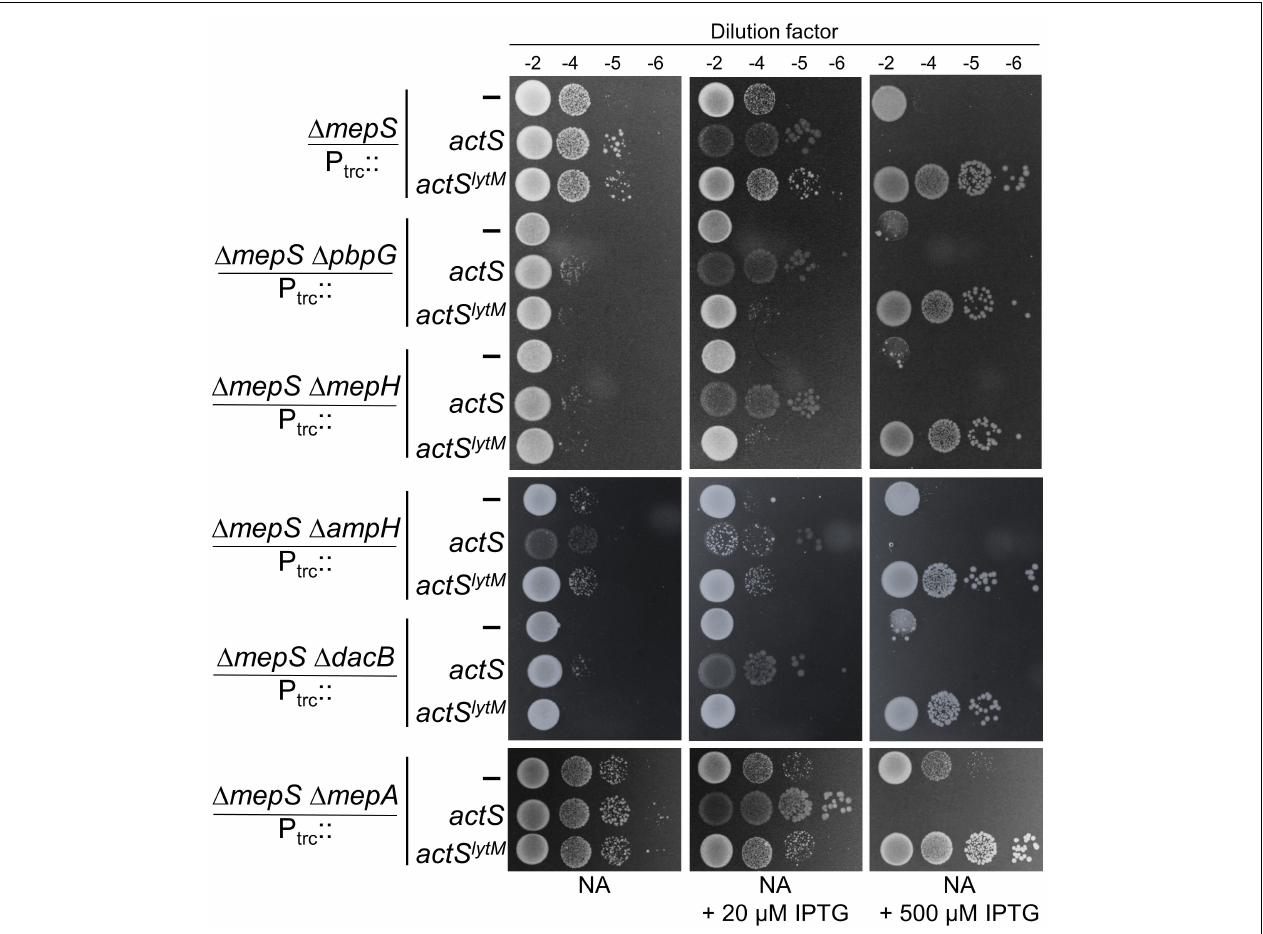
FIGURE 8 | Growth advantage to (cid:49) mepS mutant by ActS is not mediated by D,D -endopeptidases. (cid:49) mepS mutant and its derivatives carrying pTRC99a vector (P trc ::empty), vector encoding actS (P trc :: actS ), or actS lytM (P trc :: actS lytM ) were grown in LB and tested for viability on NA plates supplemented with and without IPTG at 37 ◦ C.